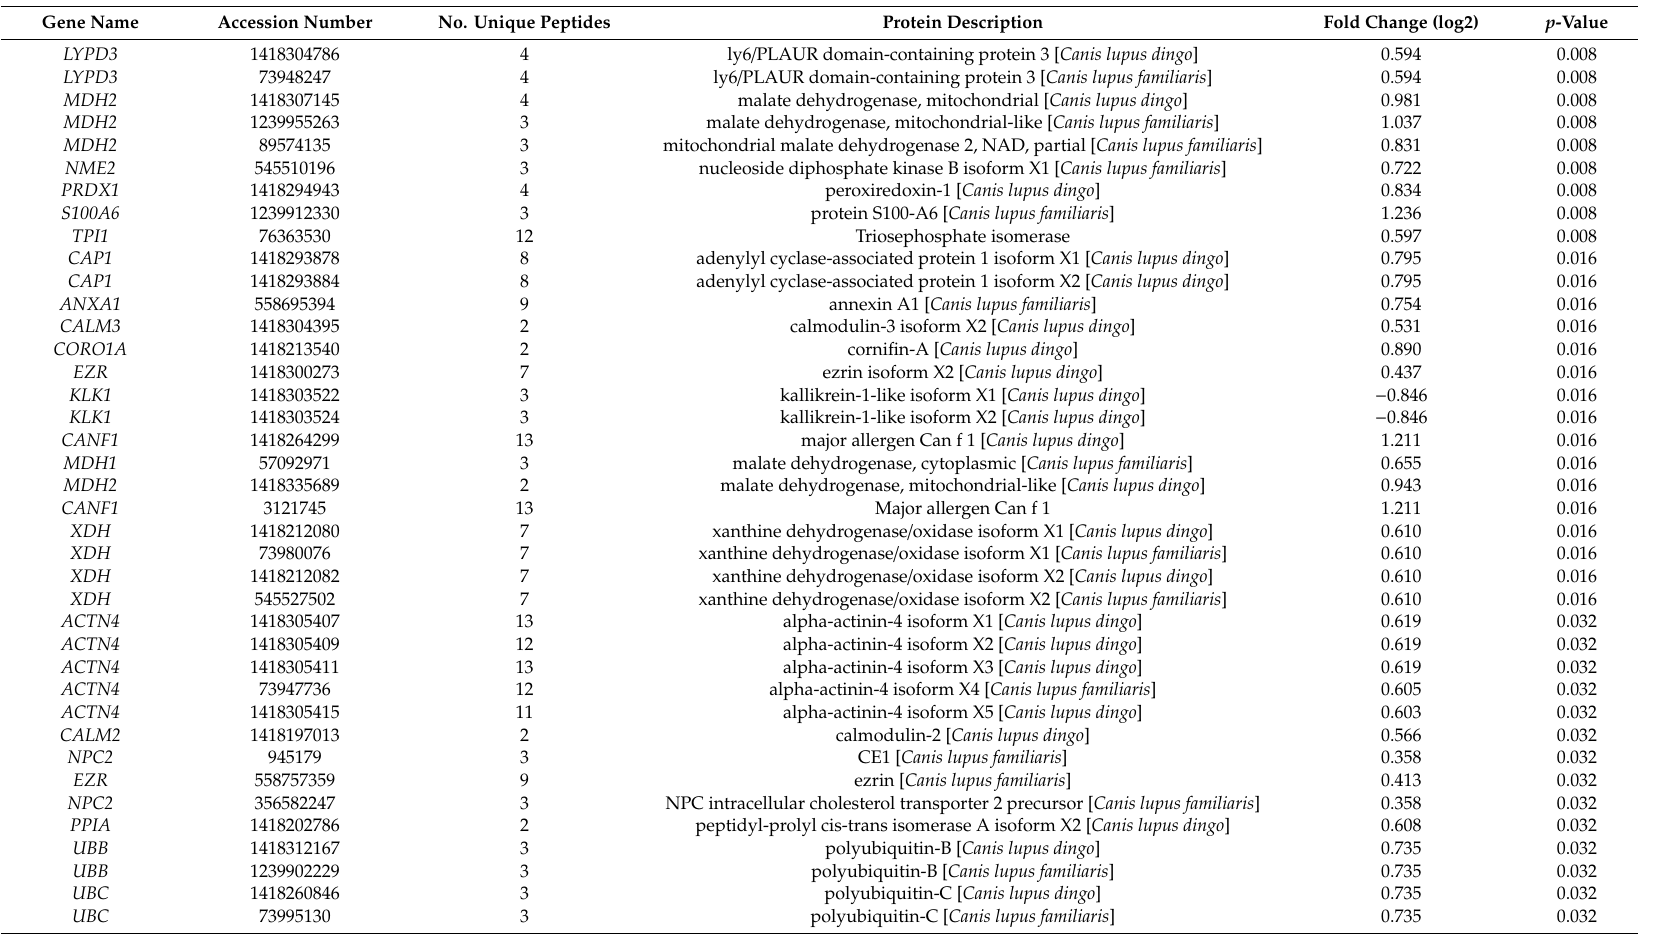
Table A2. Salivary proteins identified in dogs with canine mammary tumors (CMT) and healthy controls